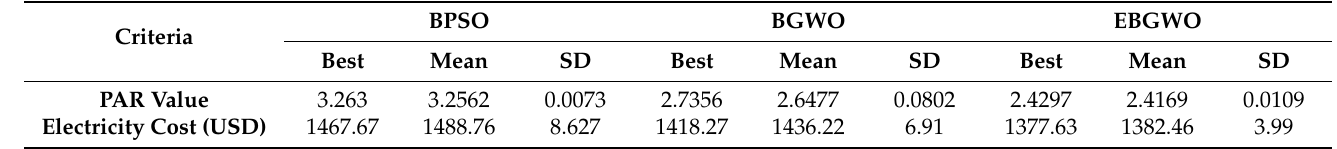
Table 3. PAR and cost values after implementing algorithms.